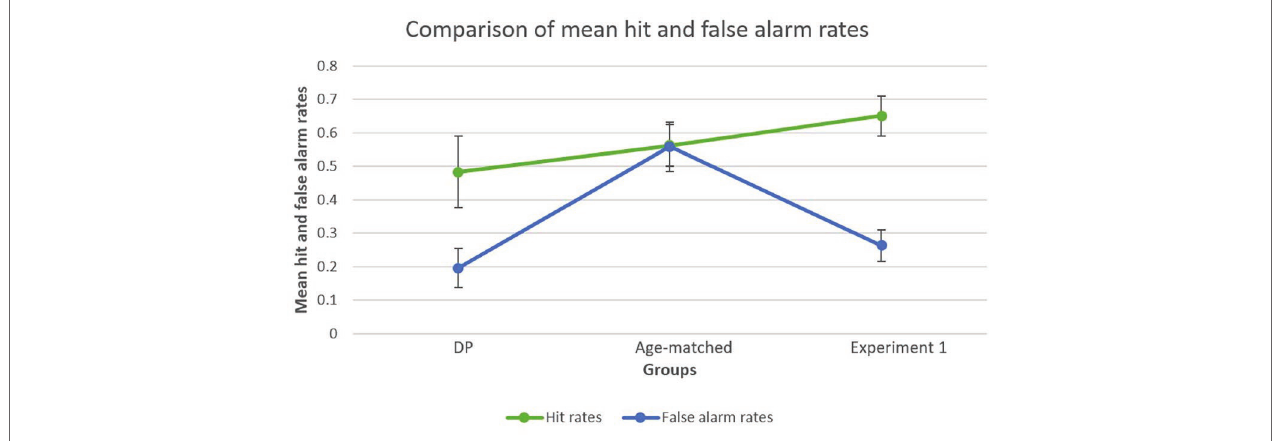
FIGURE 4 | Mean false alarm rates and mean hit rates within each group. Both the DP group and the young adult group (Experiment 1) showed a marked difference between mean hit rates and mean false alarm rates, whereas the age-matched group showed similar hit and false alarm